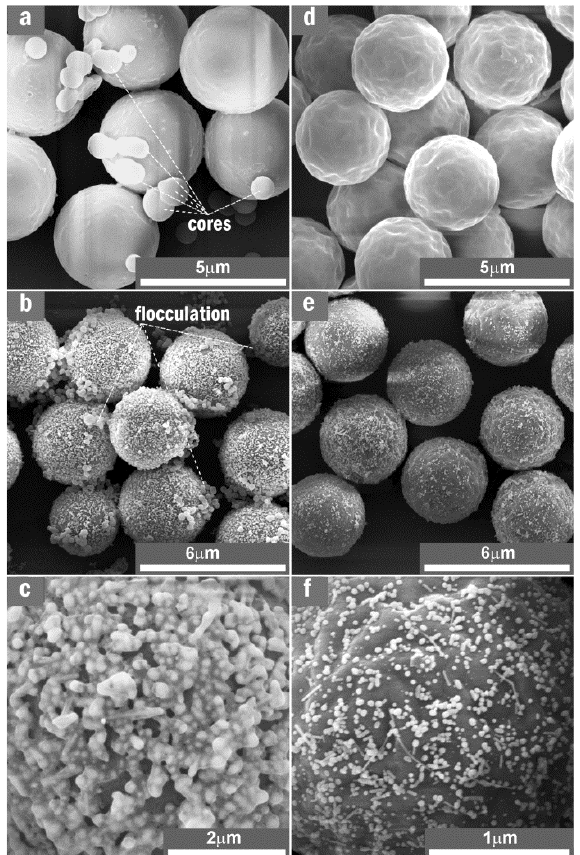
Figure 3. Impact of the acid-treatment reaction on SEM images of the MF 3 microspheres and AgNP/MF 3 substrate: ( a ) and ( d ) were collected on non-treated and the acid-treated MF 3 micro- spheres; ( b ) and ( e ) were collected on substrates incorporating the MF 3 samples of ( a ) and ( d ); and ( c ) and ( f ) were amplified from ( b ) and ( e ), respectively. After the acid-treatment reaction, the AgNPs were well dispersed on the surface of the microsphere.